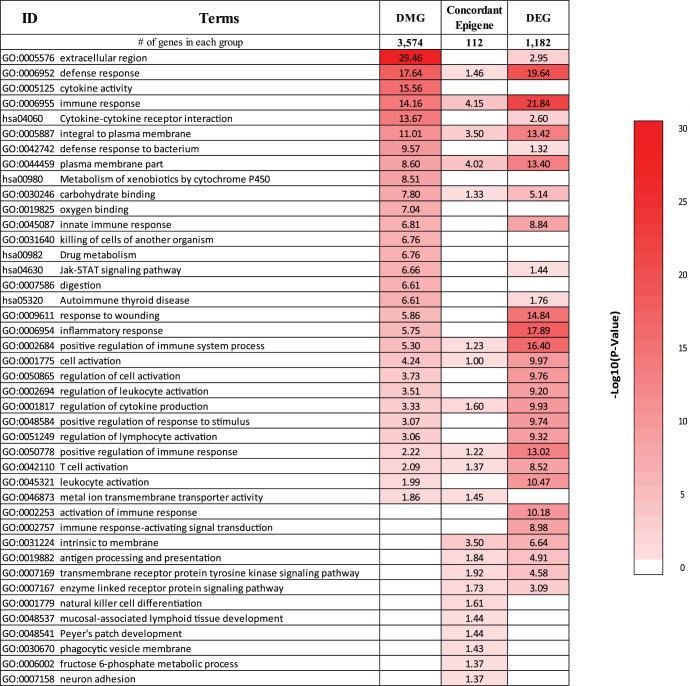
Biological functions of DMGs, DEGs, and concordant epigenes.Overrepresented biological functions were identified using DAVID. The top 20 biological functions ordered by p-value were collected from each gene set, and redundant terms were combined. The values in the table correspond to -log10 (DAVID p-value), ranging from 0 (white) to 30 (bright red). The values are not normalized across different gene sets with variable numbers of genes. The order of biological terms was based on the log-transformed p-values of DMGs and DEGs.